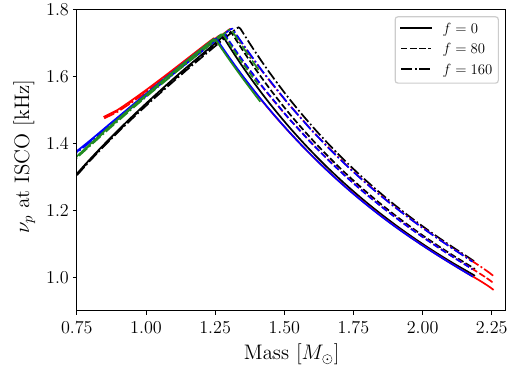
Fig. 13 Orbital frequency at the ISCO radius as a function of the grav- itational mass for GR and TMST with the monotonic coupling function (12), for n = 1 and different β values. Solid lines denote static config- uration while dashed and dash-dotted lines correspond to the f = 80 Hz and f = 160 Hz cases. Colors scheme follows Fig. 10